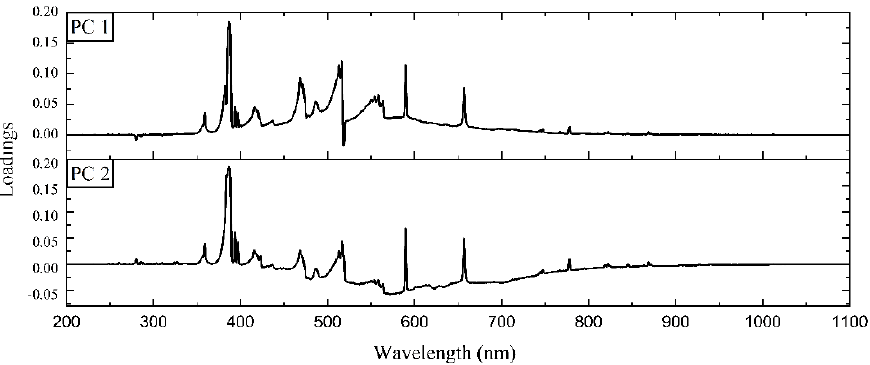
Figure 6. Loadings plots for the first two Principal Components (PCs).